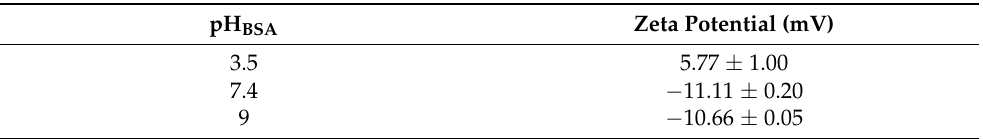
Table 1. Zeta potential values of bovine serum albumin (BSA) solutions for which the pH was adjusted at 3.5, 7.4, and 9. The BSA protein was dissolved at a fixed concentration of 10 − 1 mg/mL.